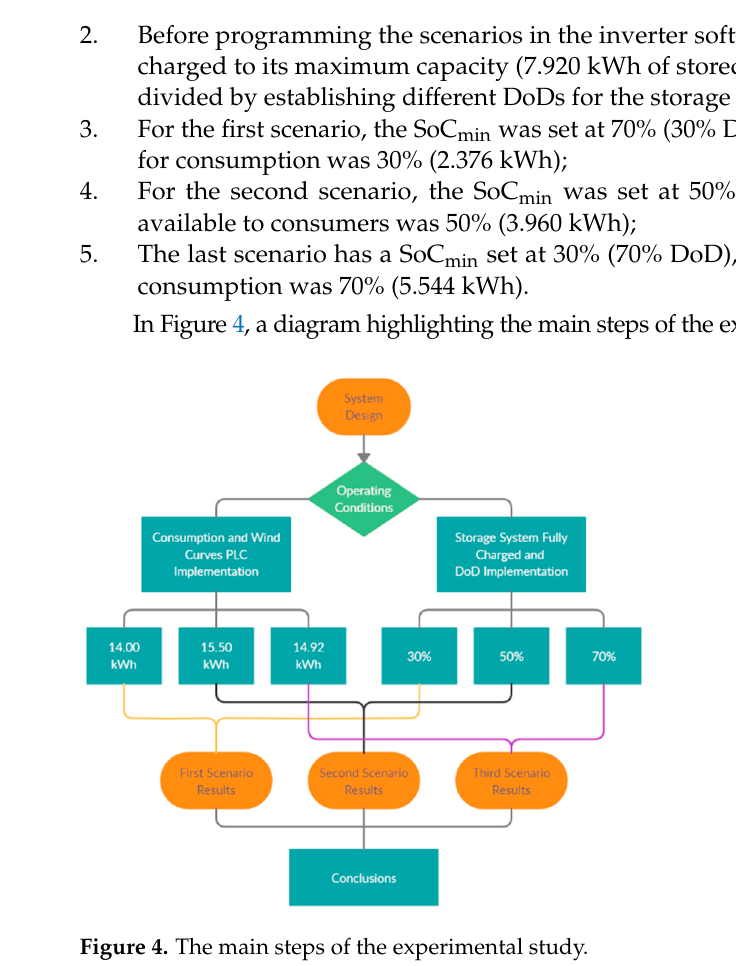
Figure 4. The main steps of the experimental study.